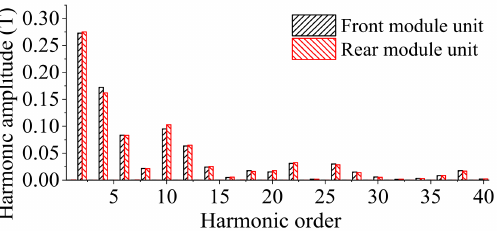
Figure 14. Armature reaction air-gap flux density harmonic distributions for AMC-FRPM